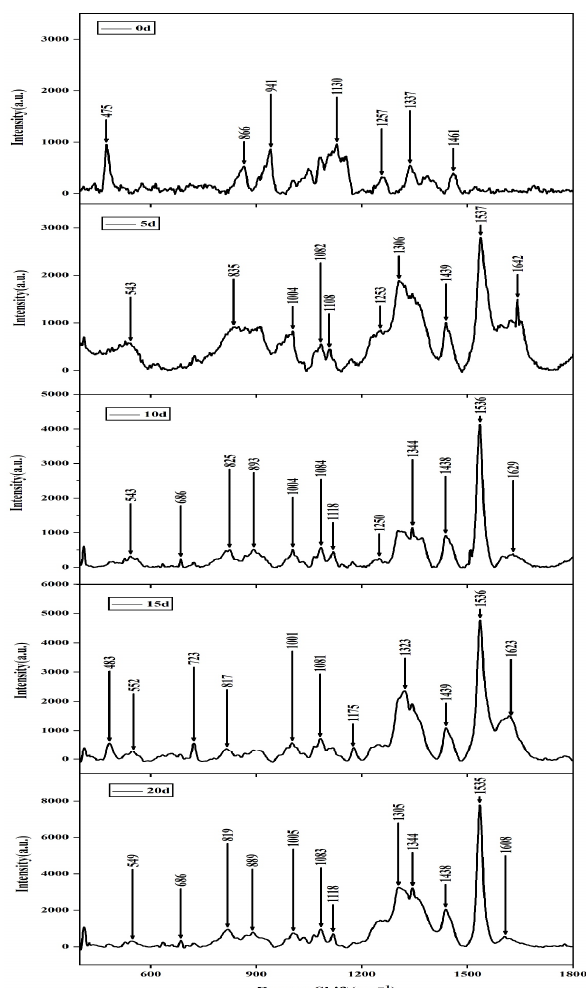
Figure 4. SERS of Aspergillus flavus on corn in different culture periods.